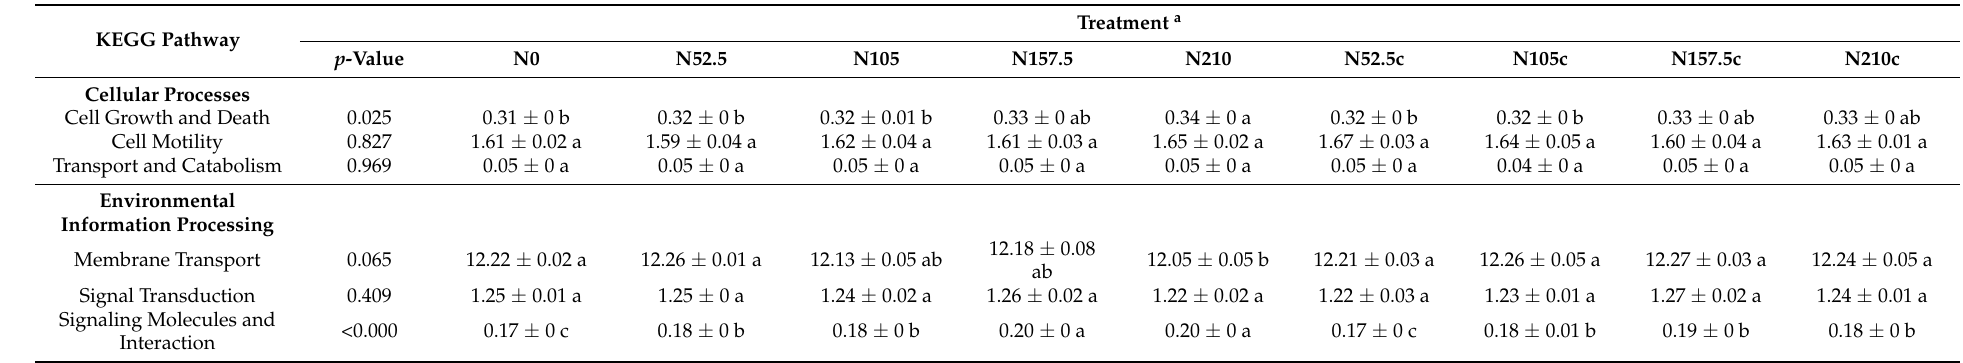
Table 2. The soil bacterial communities top seven predicted functions related to the second level of the KEGG pathway as affected by N